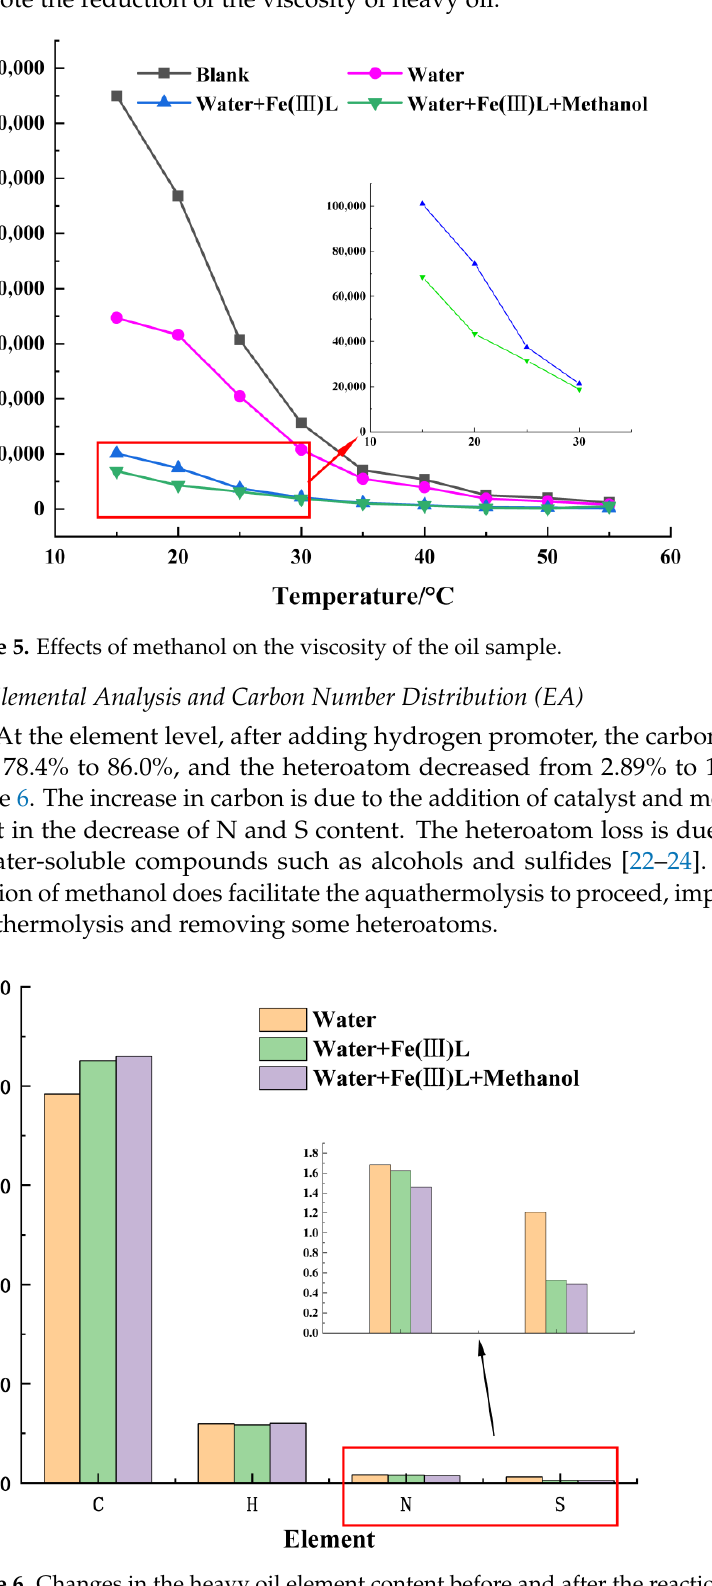
Figure 6. Changes in the heavy oil element content before and after the reaction.